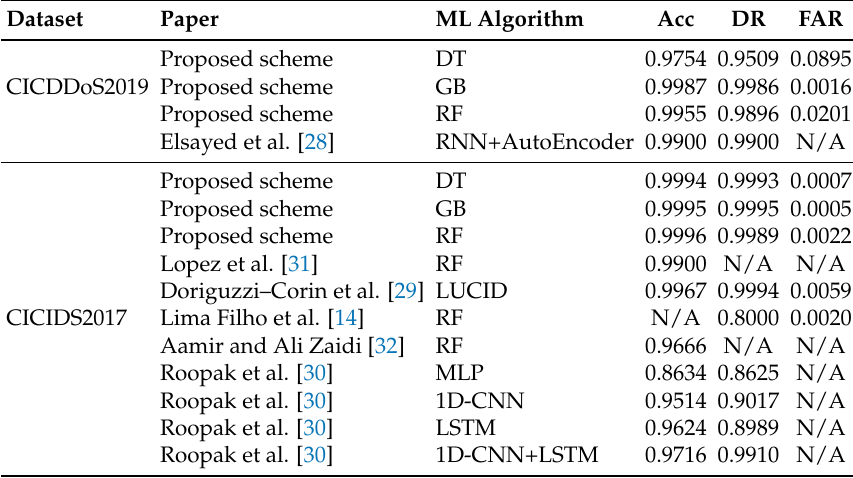
Table 6. Comparison between the proposed technique and related